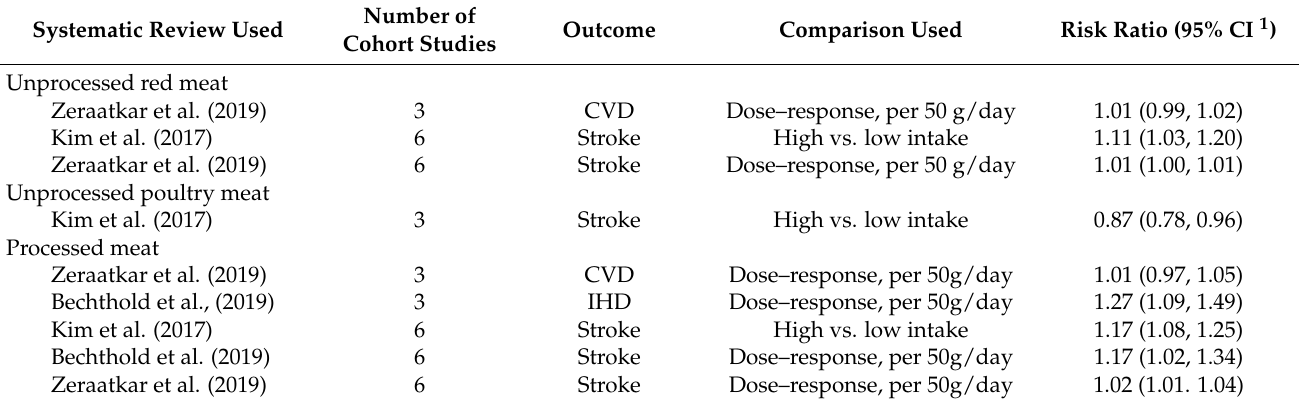
Table 2. Meta-analyses of associations between meat type and risk of CVD, IHD and stroke (from